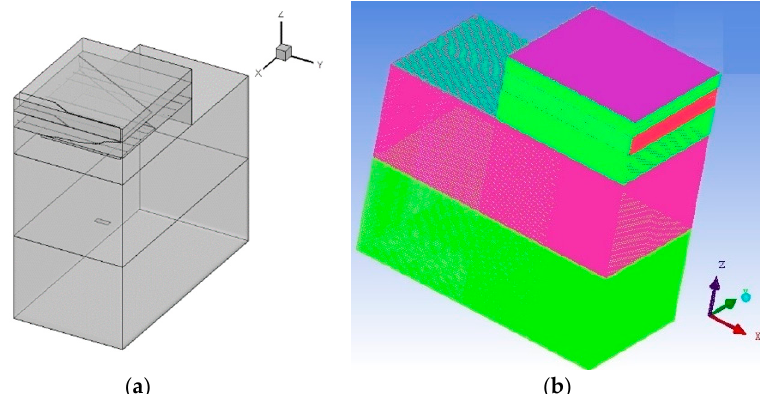
Figure 3. Three-dimensional (3D) and Meshing models of the frost chamber, in the figure: ( a ) was the 3D model; and, ( b ) was the meshing